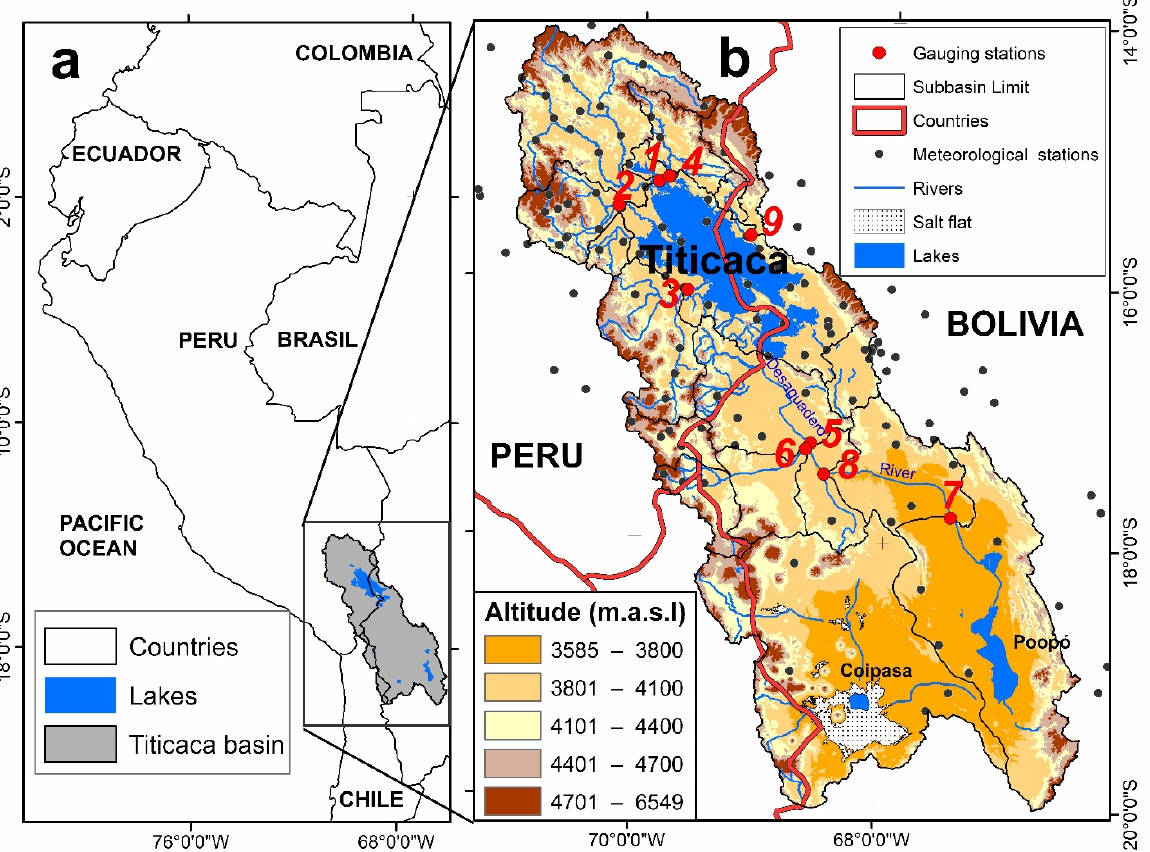
Figure 1. ( a ) Location of the Lake Titicaca, Desaguadero River, and Lake Poopo basins (TDPS system) in South America ( b ) TDPS, gauging stations (red dots), rainfall, and/or temperature stations (black dots).